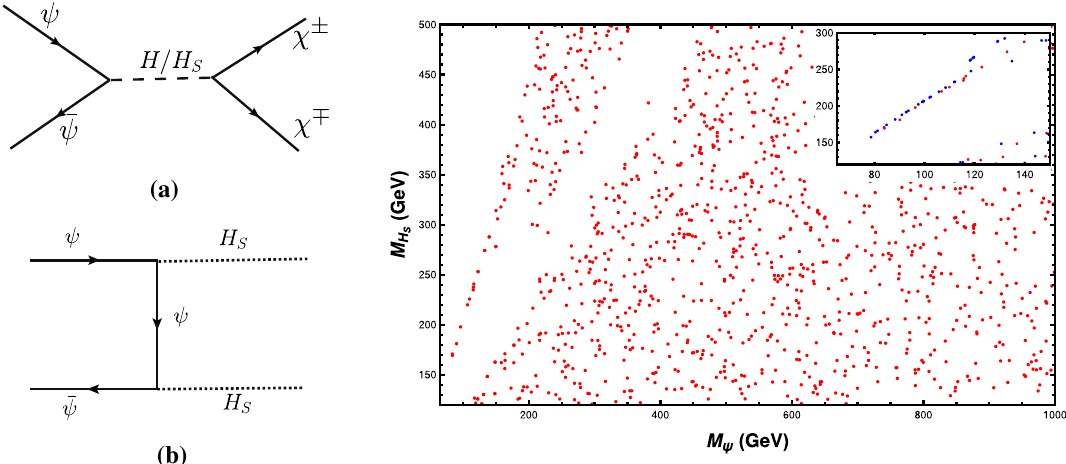
− M ψ with (cid:13) 2 within the allowed relic density range. Inset: low mass region is enlarged for clarity. The blue tot h S